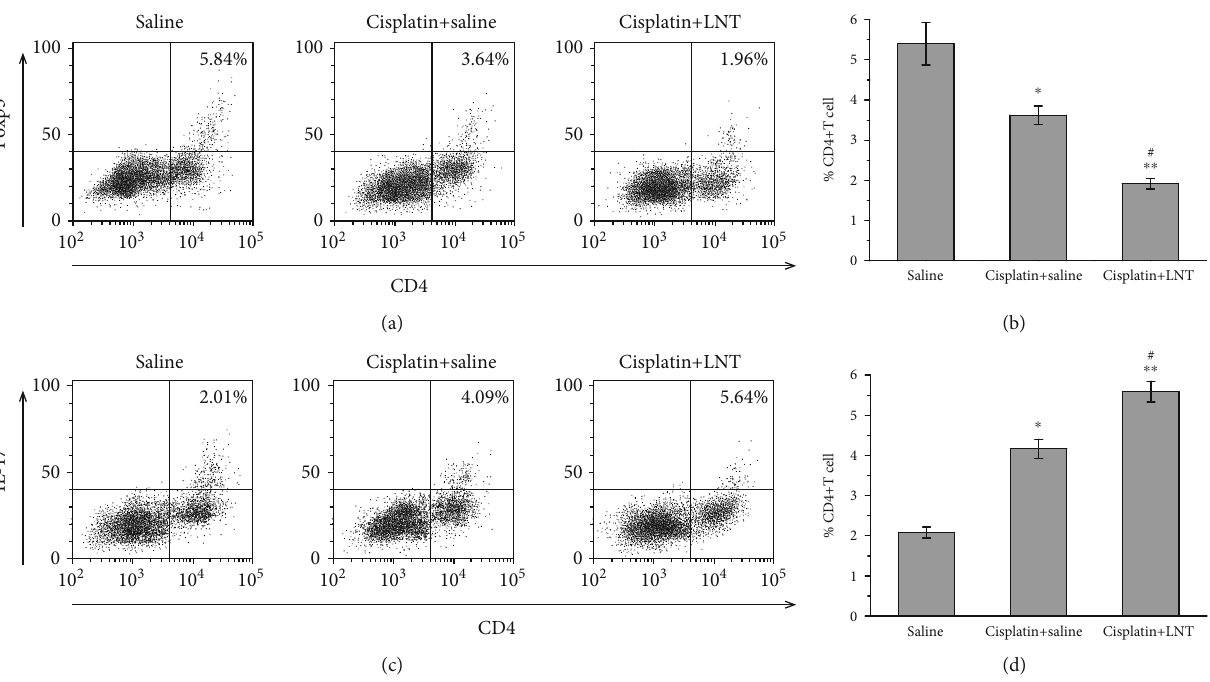
Figure 7: Change of Treg and Th17 cells in tumor tissues of human non-small cell lung cancer-bearing mice. (a, b) Tregs in mouse tumors were signi fi cantly reduced after the combined treatment of lentinan and cisplatin. (c, d) Th17 cells in mouse tumors were signi fi cantly increased after the combined treatment of lentinan and